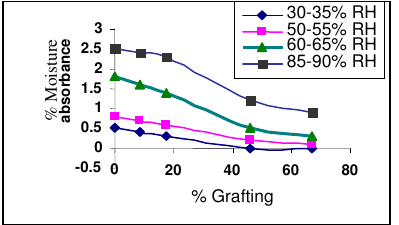
Figure 6. Effect of humidity on graft